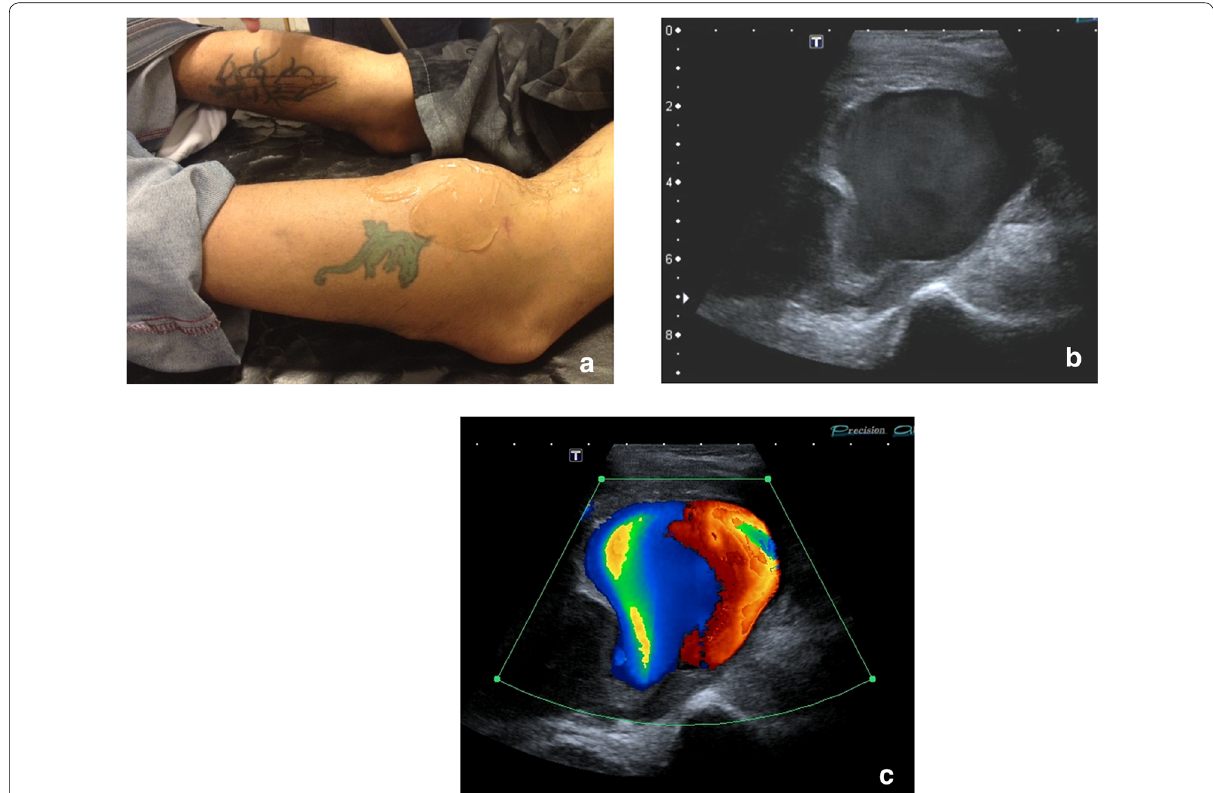
Fig. 15 Popliteal pseudoaneurism (gun shot wound one week before). a Left popliteal mass. b B mode: hipoechoic liquid image with swirling movements in real time. c Color Doppler: Yin Yang colorized